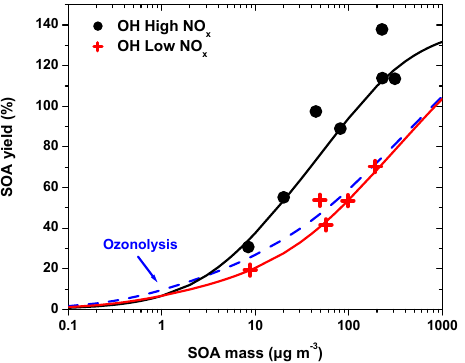
Figure 3. The SOA yield versus the total aerosol mass produced. The red dots represent the experiments when photolysis of HONO was used as a source of hydroxyl radicals, and the black dots are for the photolysis of H 2 O 2 . The dashed line corresponds to the SOA yield from the ozonolysis of β -caryophyllene.